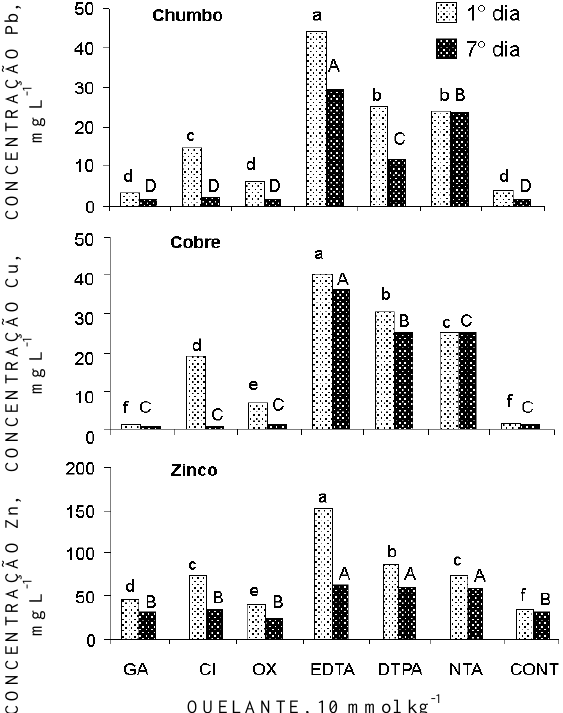
Figura 1. Concentração de Pb, Cu e Zn na solução do solo no 1° e no 7° dia após as aplicações dos quelantes. GA, ácido gálico; CI, ácido cítrico; OX, ácido oxálico; CONT, controle. As letras minús- culas comparam os tratamentos no 1° dia e as maiúsculas comparam os tratamentos no 7° dia. Letras iguais não diferem estatisticamente (Teste Scott-Knott, P <